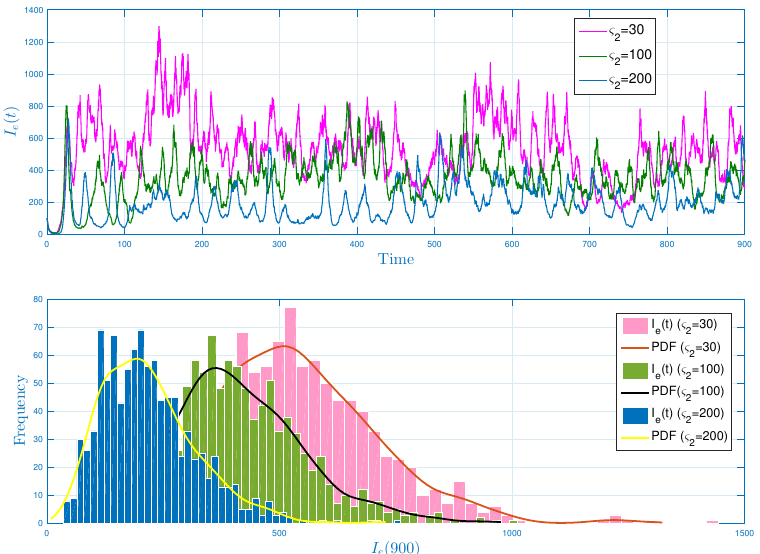
Figure 6. The first row represents the paths of the affected category for the following different time lags: ς 2 = 30, ς 2 = 100 and ς 2 = 200. The second row shows the associated histograms and the probability density functions for I s